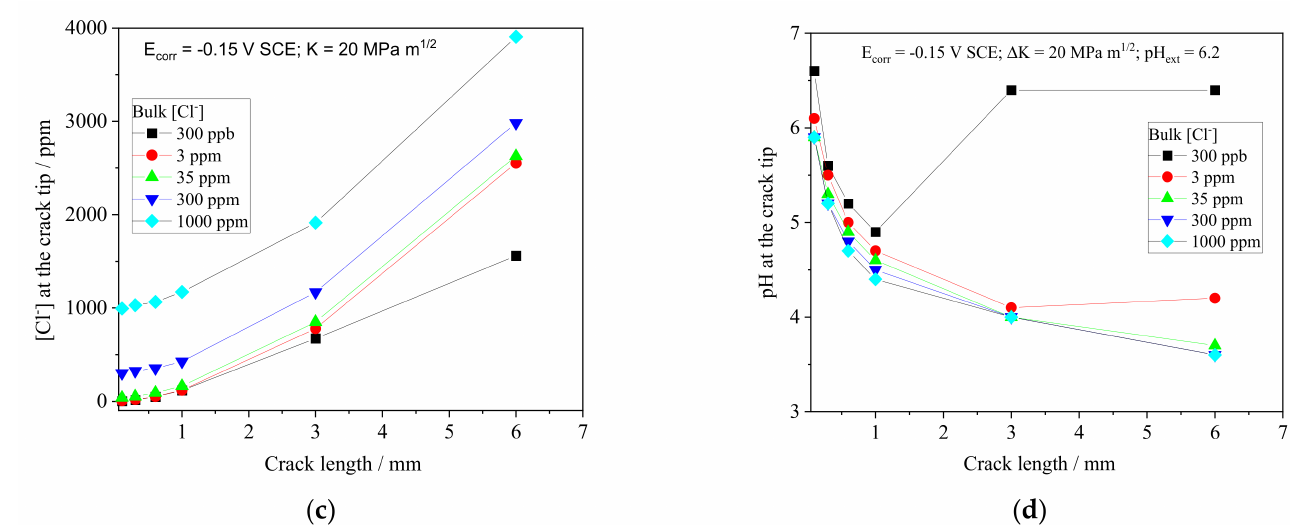
Figure 9. Modelling of crack-tip electrochemistry for FV566 12Cr MSS in chloride solution of low conductivity, reprinted with permission from [29] Copyright 2017 Crown Copyright: ( a ) schematic of processes involved; ( b ) dependence of crack-tip potential on crack length and chloride ion concentration; ( c ) crack-tip chloride ion concentration; ( d ) crack-tip